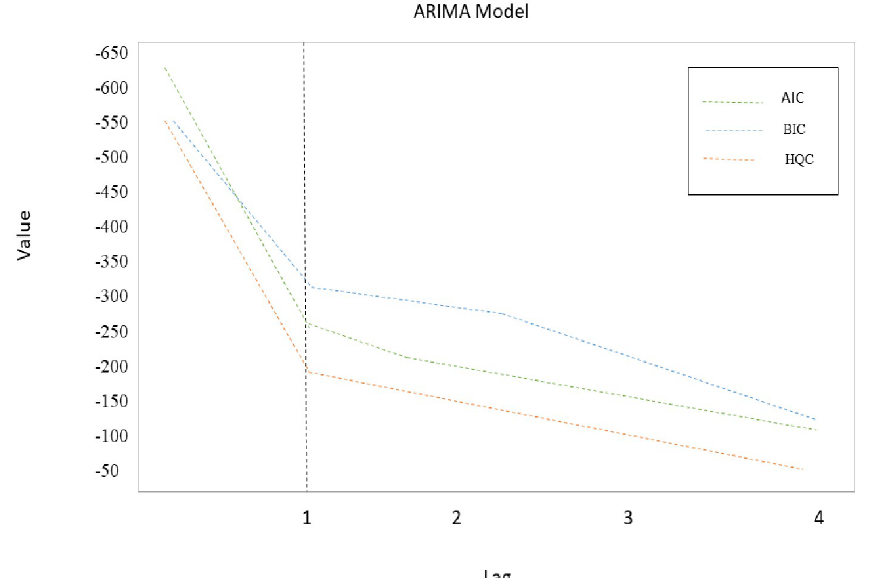
Fig 2. Order(d) selection of ARIMA model for unemployment data